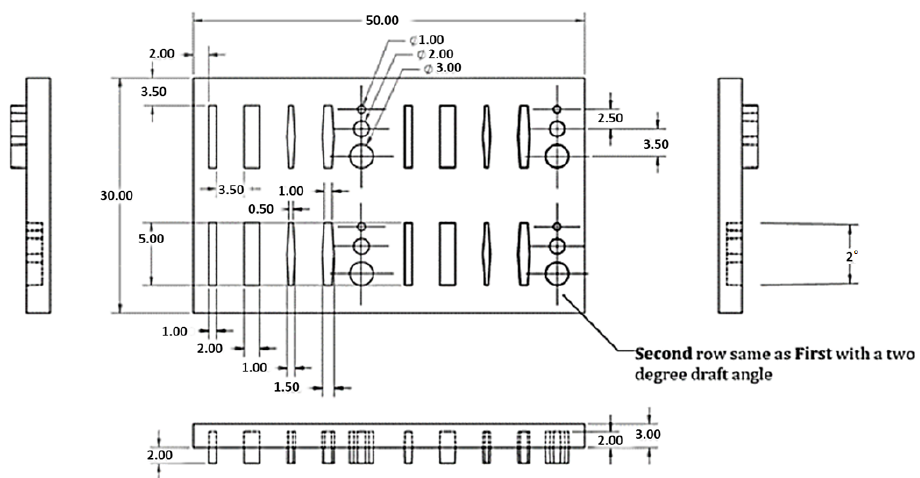
Figure 1. Design of selected test artefact for dimensional accuracy evaluation of the 3D printed parts.